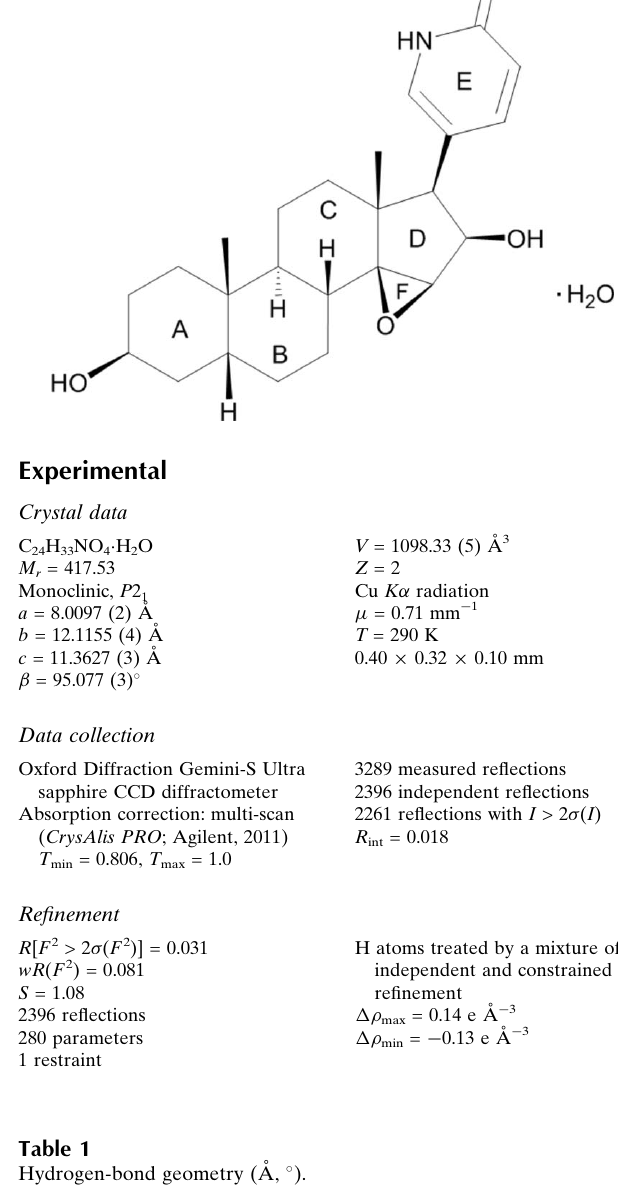
Hydrogen-bond geometry (A˚ , (cid:3) ). D —H (cid:2)(cid:2)(cid:2)